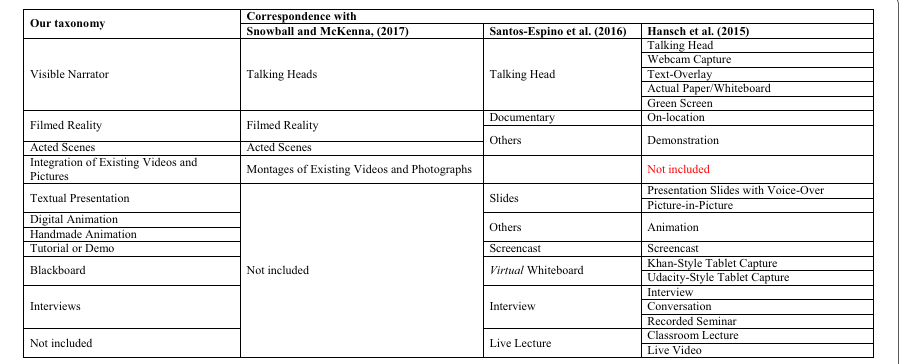
Fig. 3 Mapping between styles in authors’ taxonomy and others by extending the Santos-Espino et al.